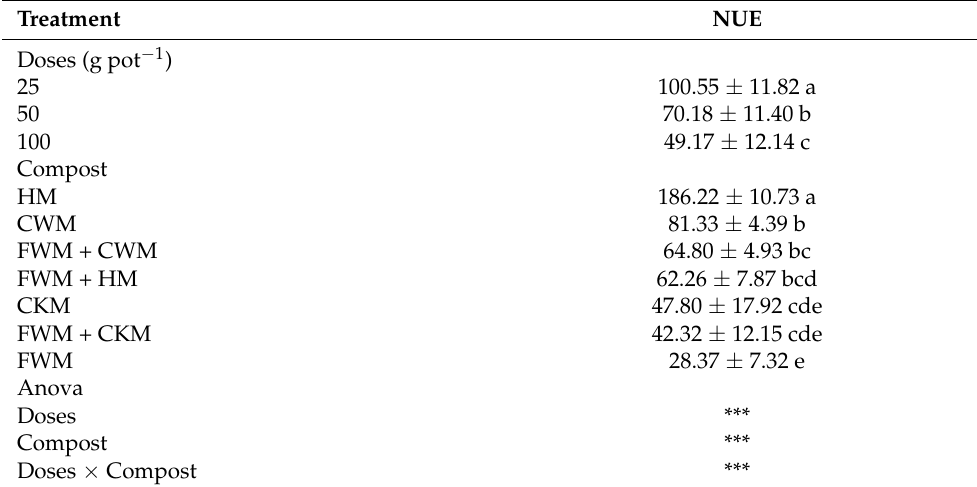
Table 5. Nitrogen use efficiency (NUE) of Komatsuna under different doses and compost.